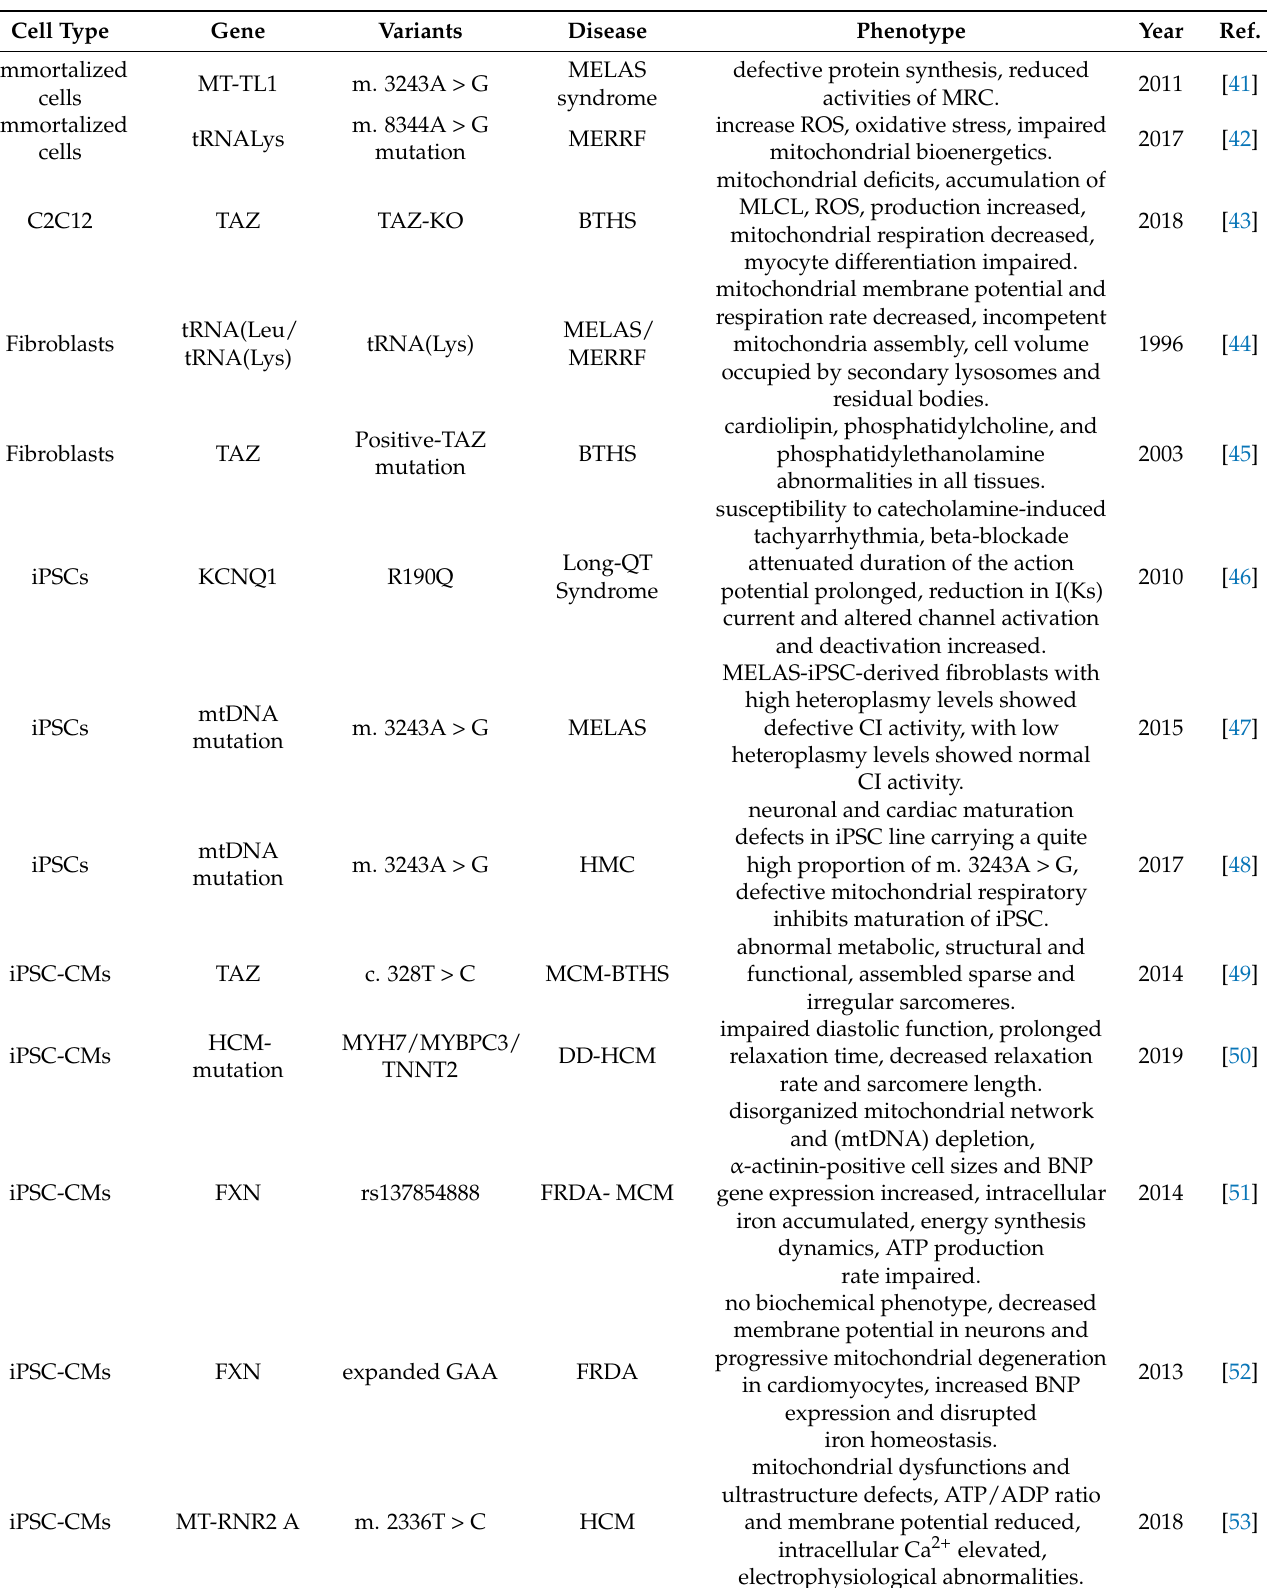
Table 3. List of the cellular models used in